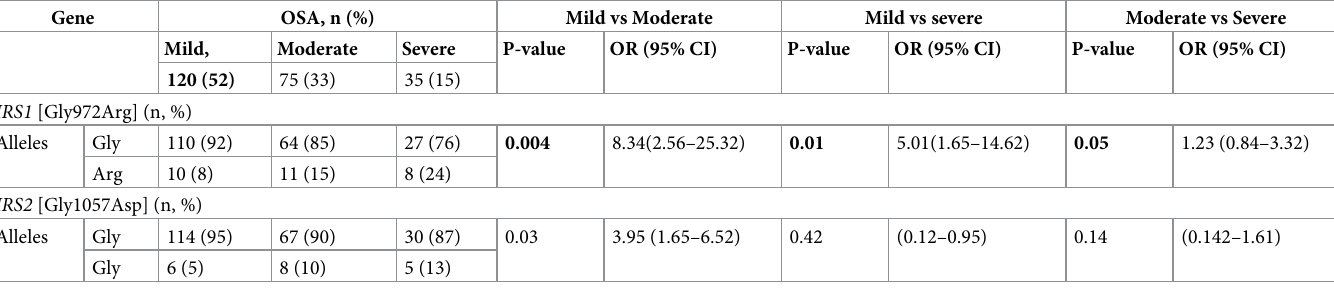
Table 5. Allele distributions in patients according to the severity of